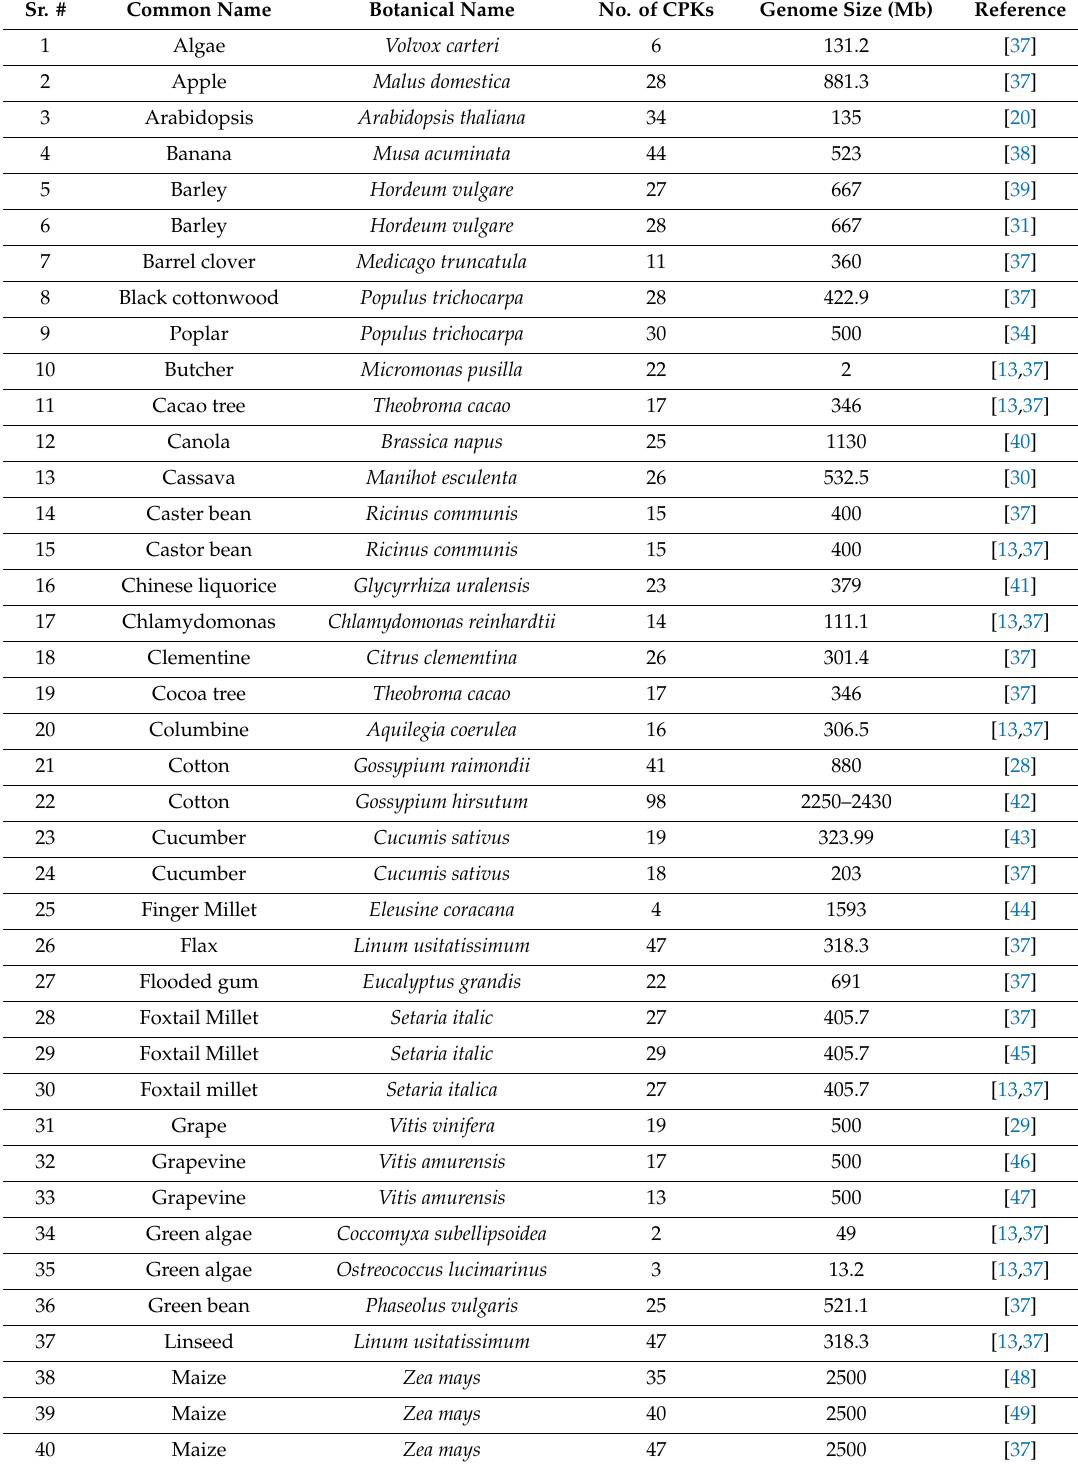
Table 1. Genome-wide identification of calcium-dependent protein kinases (CPKs) among various plant